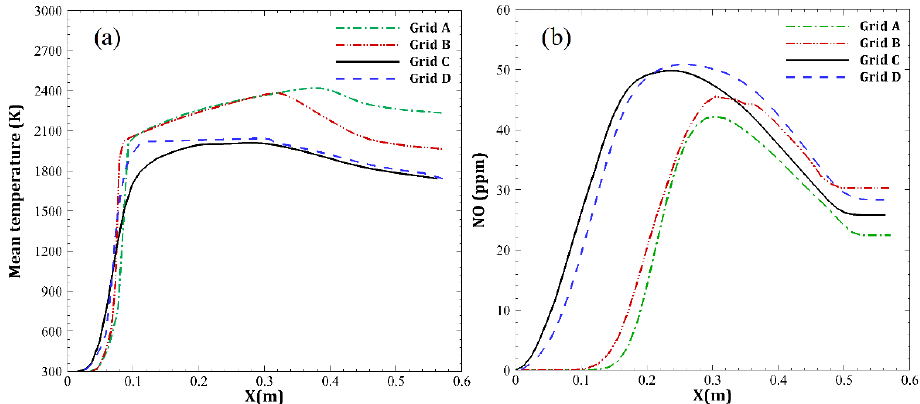
Figure 2. Independence evaluation of grid: ( a ) mean temperature, ( b ) NO concentration on center line (Y = 0, Z = 0).